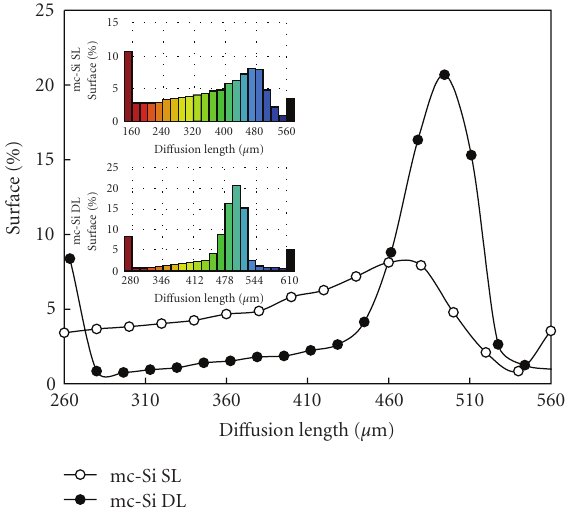
Figure 6: Comparison average di ff usion length of the SL and DL antireflection deposition in large size mc-Si solar cell. Histograms of di ff usion length against percentage wafer area for SL and DL coating solar cells are shown in the up-left inset.